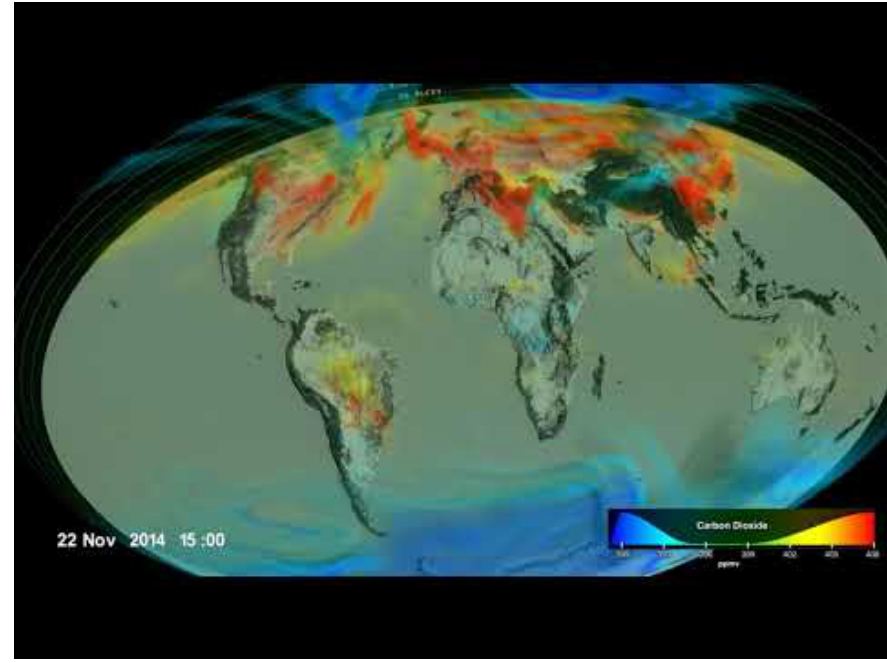
Figure 1: Clip from climate model visualization Carbon Dioxide from GMAO Using Assimilated OCO-2 Data (2016) showing the rotation of the visualization in three dimensions. Source: Clip made by author from original by NASA Scientific Visualization Studio. Available at https://svs.gsfc.nasa.gov/4514. URL: